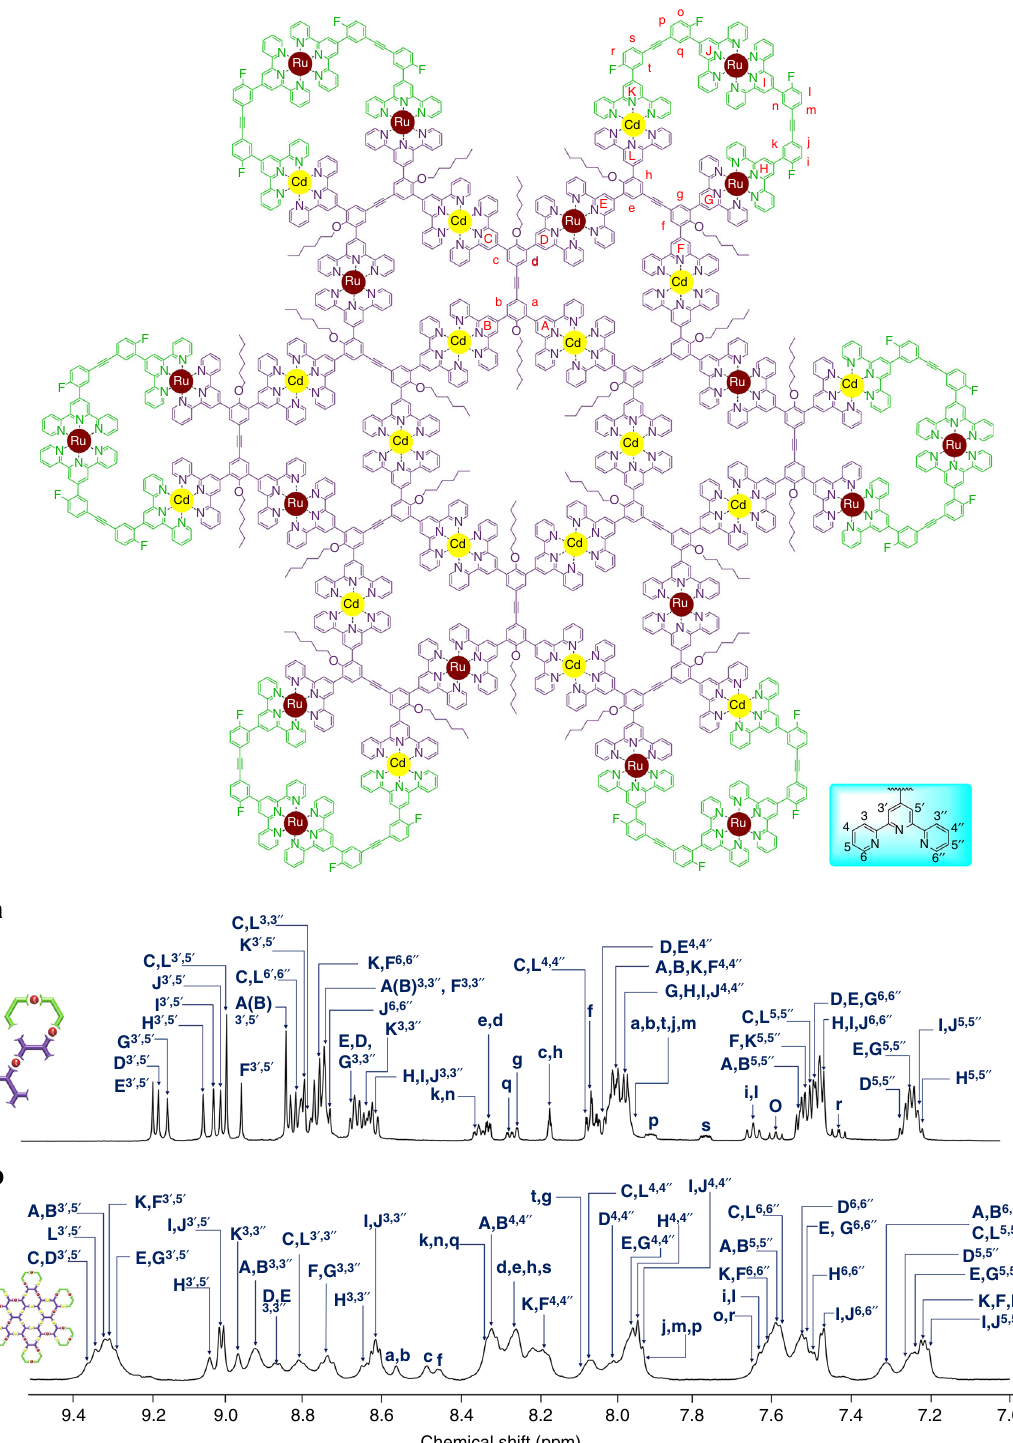
Fig. 4 1 H NMR spectra (aromatic region). a L5 (600 MHz, CD 3 CN, 300 K); b C5 (600 MHz, CD 3 CN, 300